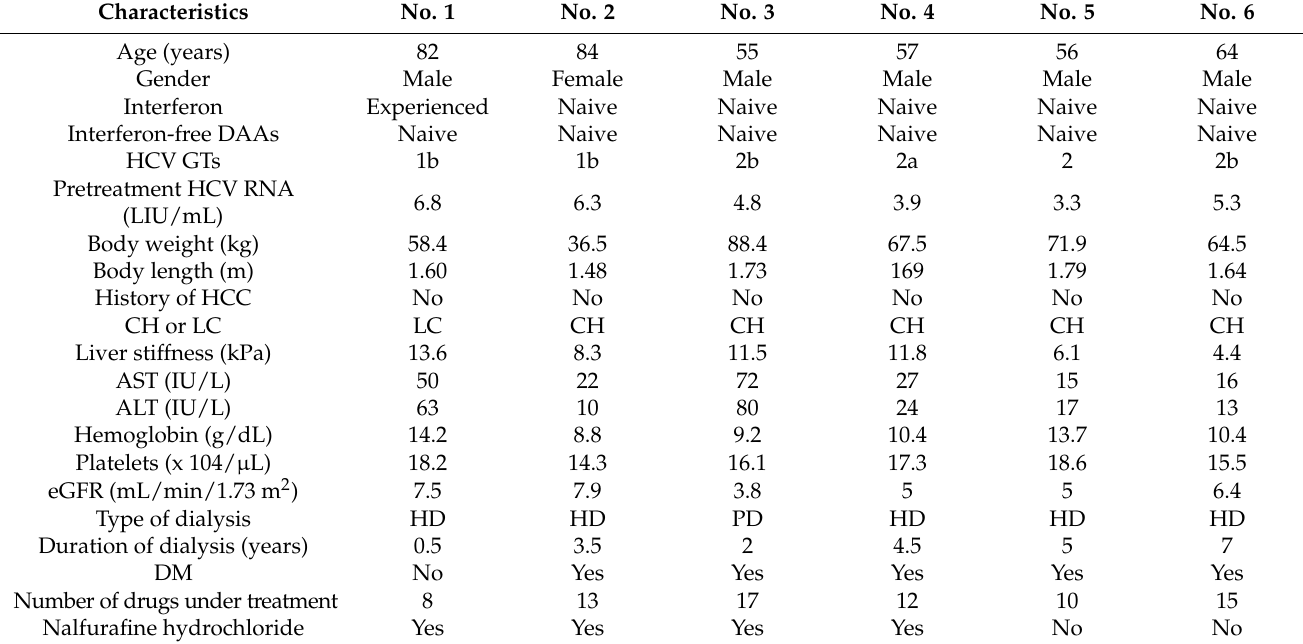
Table 3. Characteristics of six patients undergoing artificial dialysis with glecaprevir/pibrentasvir treatment.